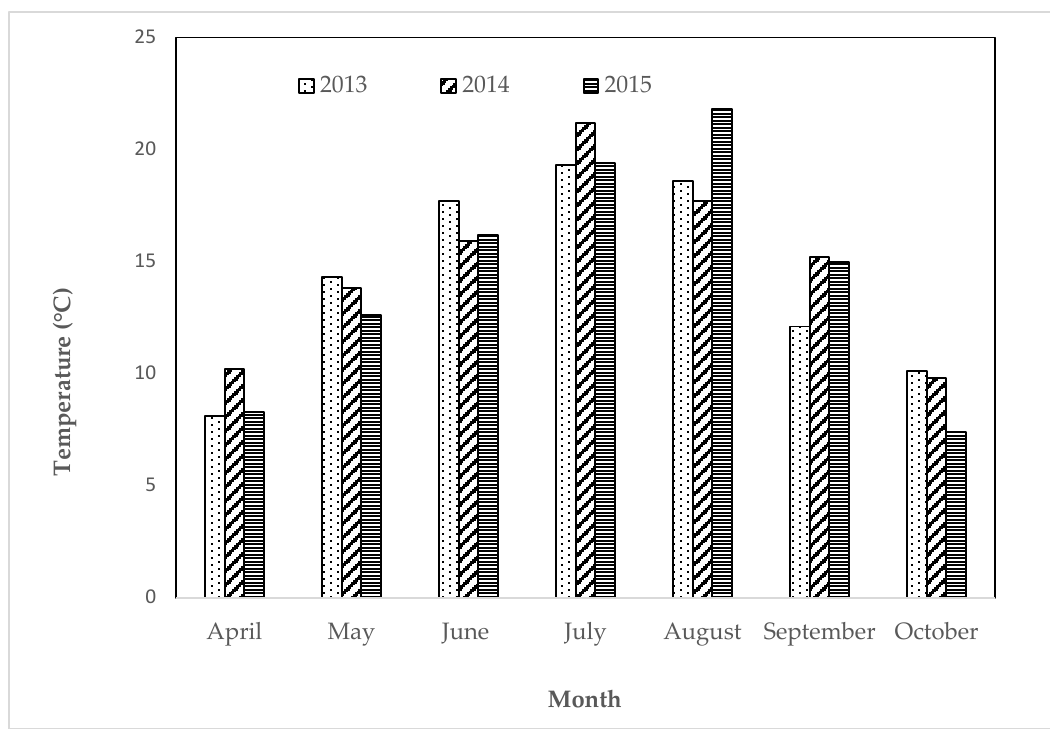
Figure 1. Mean monthly temperature in sugar beet growing season in the period of studies.